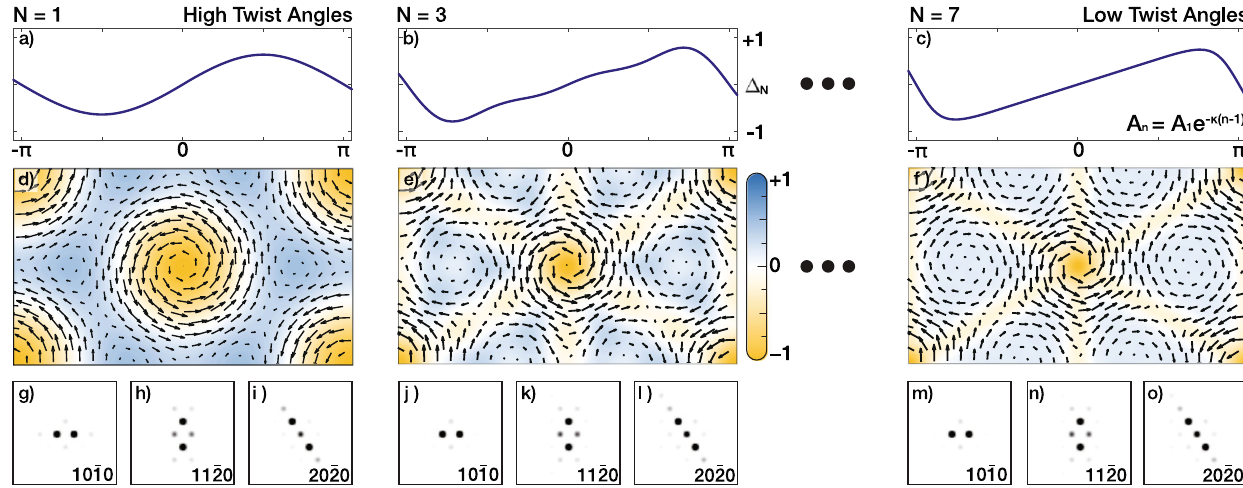
Fig. 4 | PLDs as a Fourier series in 2D Moiré materials. a – c Evolution of periodic wave ( Δ ) as higher harmonic waves b N =3, c N =7) are included; Δ is normalized displacement magnitude over one period along one direction. Fourier coef fi cients ( A n )aretailoredasexponentialdecay,whichproducestoasmooth “ sawtooth ” -like waveform.Includingharmonicwavesallowshigh-frequency(i.e.,sharp)featuresin resultant waves. d – f Torsional PLD structure with higher harmonic PLD included.